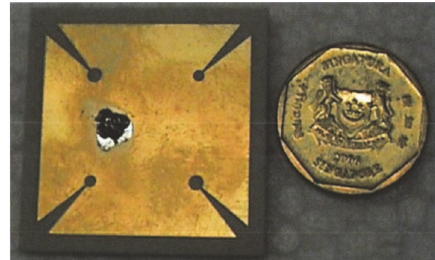
Figure 3: Compact antenna with symmetrical slit [46].